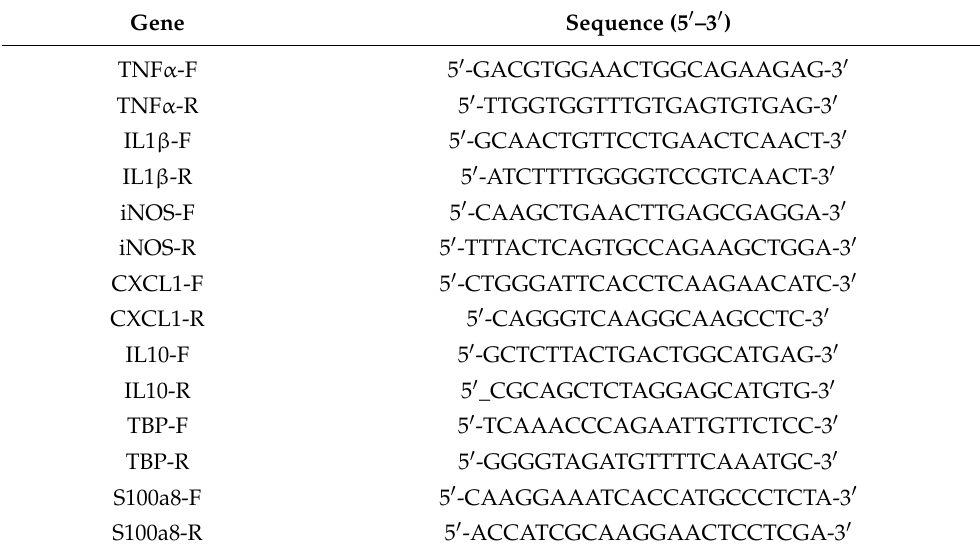
Table 1. List of primers used in